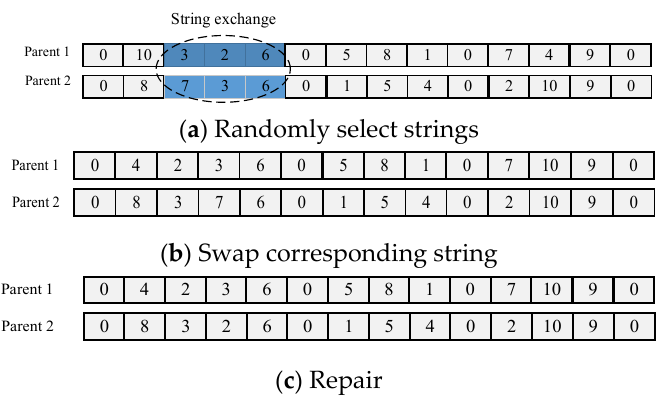
Figure 5. Schematic Diagram of Chromosome Cross Change Process.